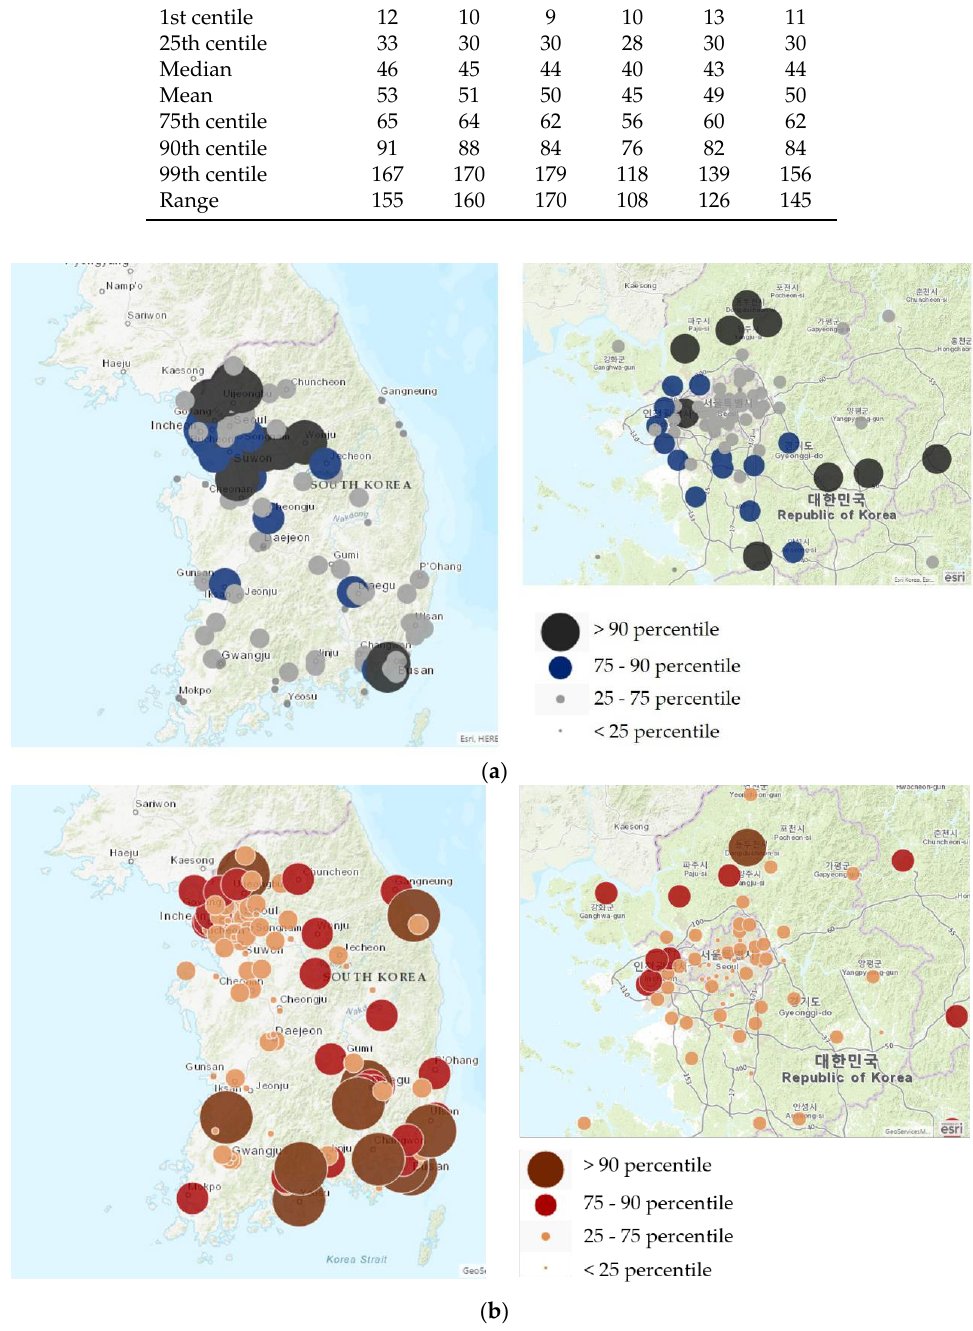
Figure 2. (a) Distribution of particulate matter less than 10 μm in Korea . ( b ) Distribution of preterm Figure 2. ( a ) Distribution of particulate matter less than 10 µ m in Korea. ( b ) Distribution of preterm births in Korea. births in Table 3. Associations of low birth weight in term infants and preterm births with quartiles of